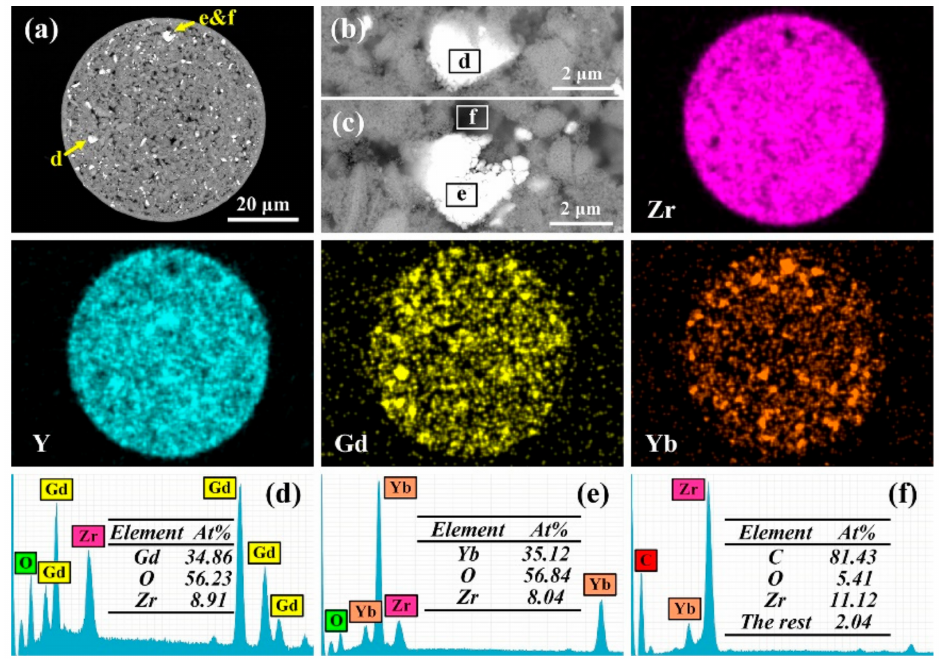
Figure 3. Cross-sectional microstructure ( a ), enlarged SEM images of the Gd-rich region ( b ) and the Yb-rich region ( c ), and corresponding EDS mapping results of Zr, Y, Gd and Yb elements of a single 10YGYZ agglomerated powder. ( d – f ) are the EDS results of the marked regions in ( b , c